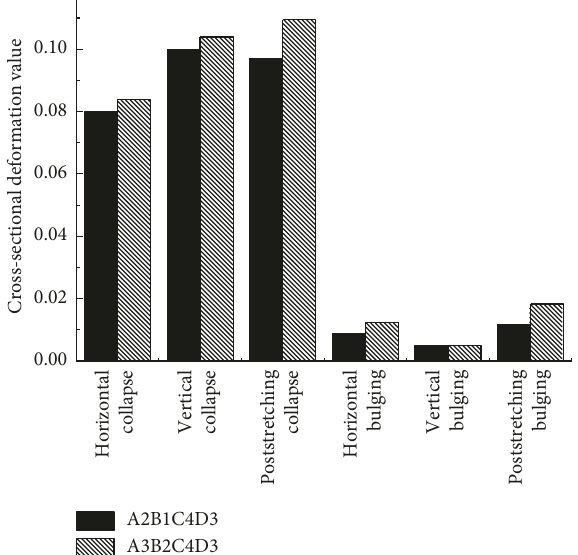
Figure 18: Cross-sectional distortion of two process parameters of forming cross section. The optimal combination of process param- eters was determined and was verified by the forming test.